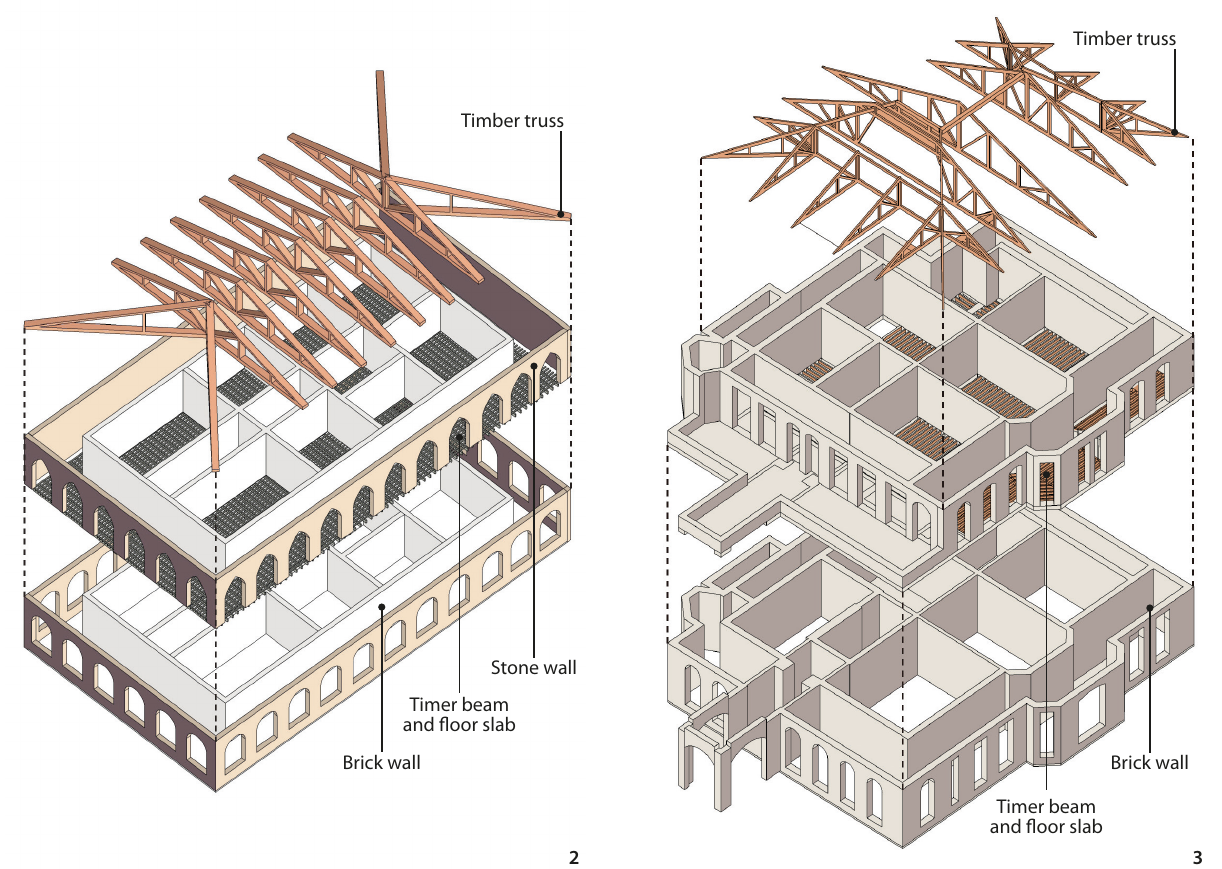
2 Figure 2 Structural Model of the 17–19 Fuzhou Road (Source: the author). Figure 3 Structural Model of the British Consulate-General (Source: the author).